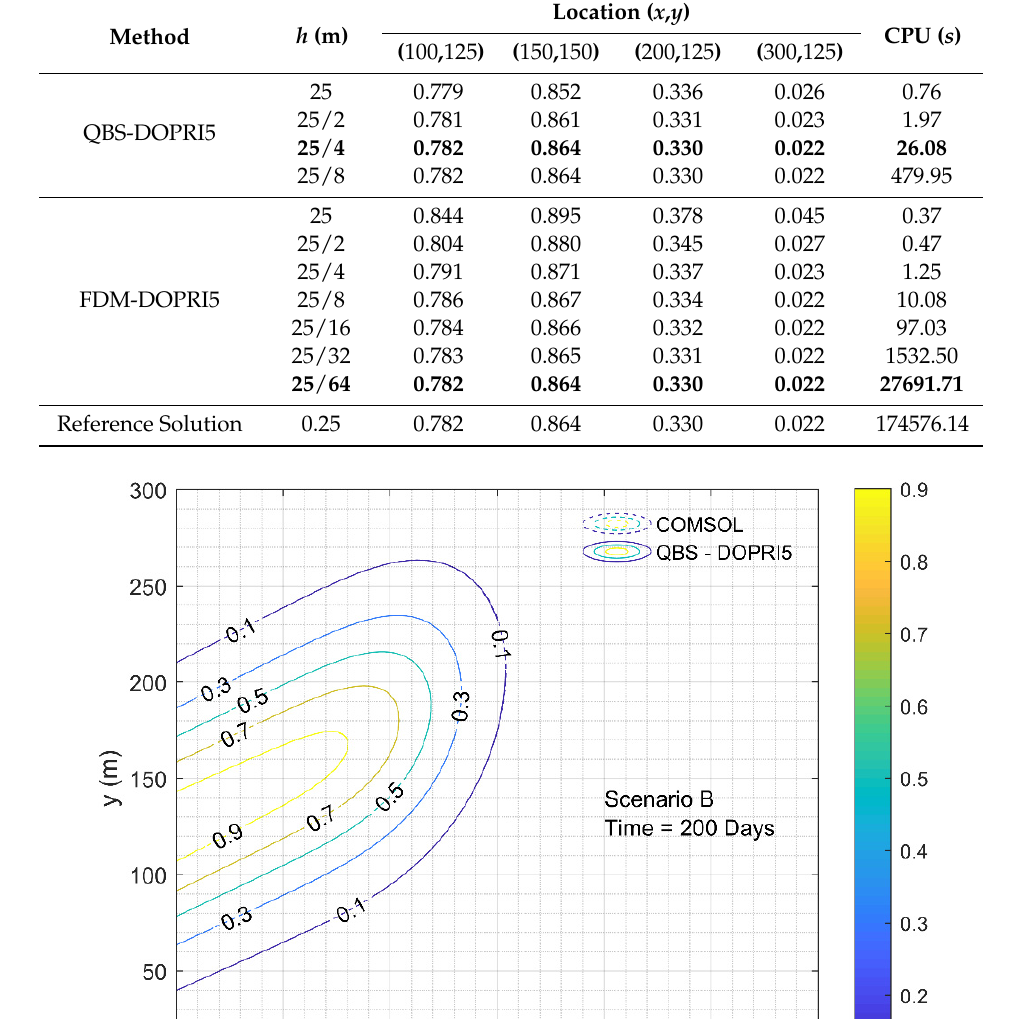
Table 8. Comparison of CPU times of QBS-DOPRI5 and FDM-DOPRI5 for different grid size and t = 200 days (Scenario B).